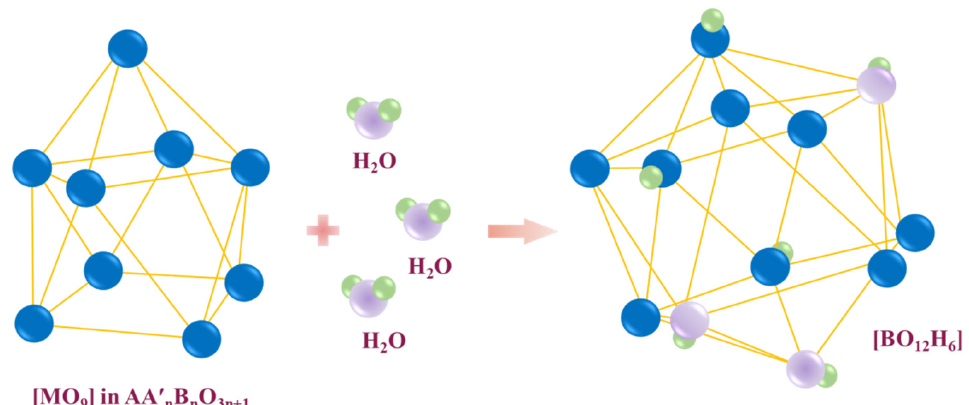
Figure 3. The schematic representation of the transformation of polyhedra [MO 9 ] to [MO 12 ] upon hydration. upon